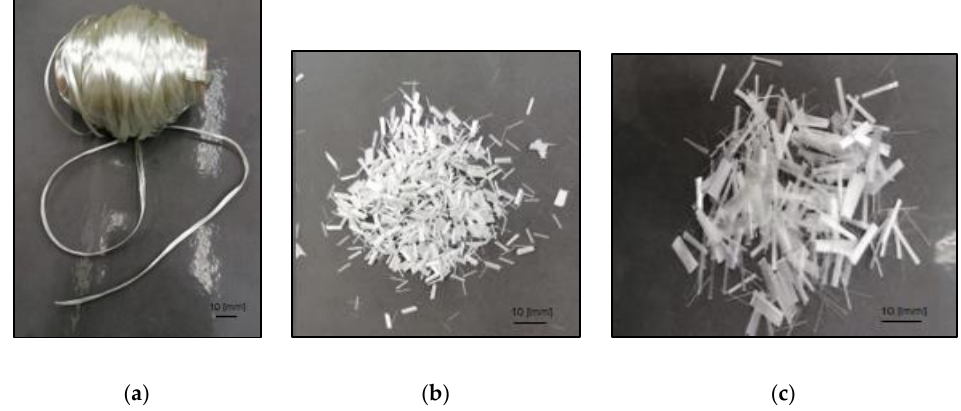
Figure 2. Type E glass fiber: ( a ) continuous; ( b ) 4.5 mm length; ( c ) 12 mm length .